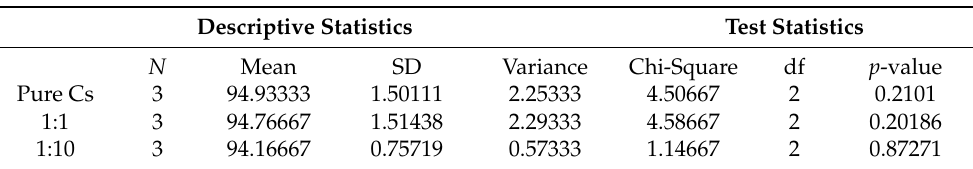
Table 4. One-sample variance test for the percentage of total live cells of each sample treatments: pure chitosan (Cs), 1:1 polyaniline–chitosan (PAni–Cs) and 1:10 PAni–Cs. Descriptive Statistics Test